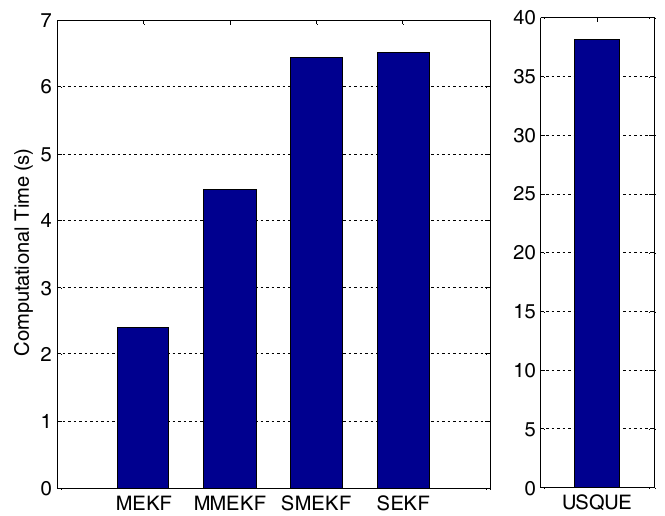
Figure 4. Averaged estimator runtime.